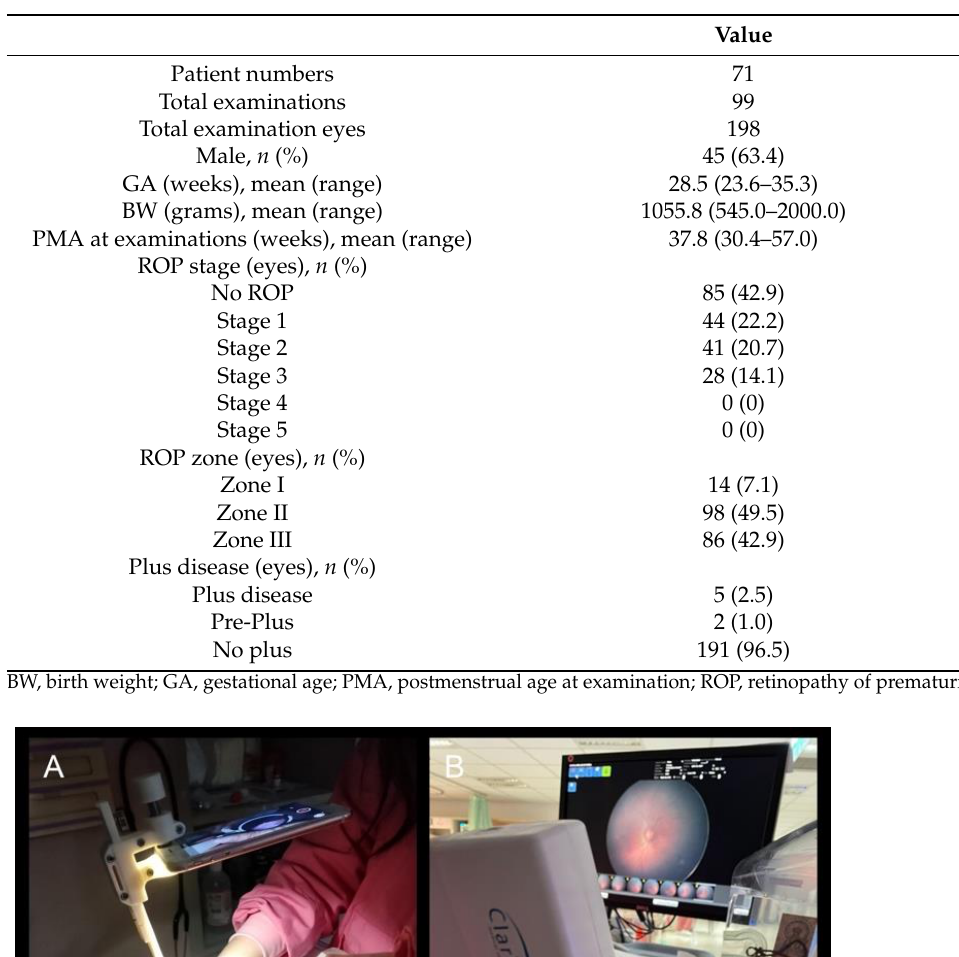
Table 1. Demographic data of the study population.